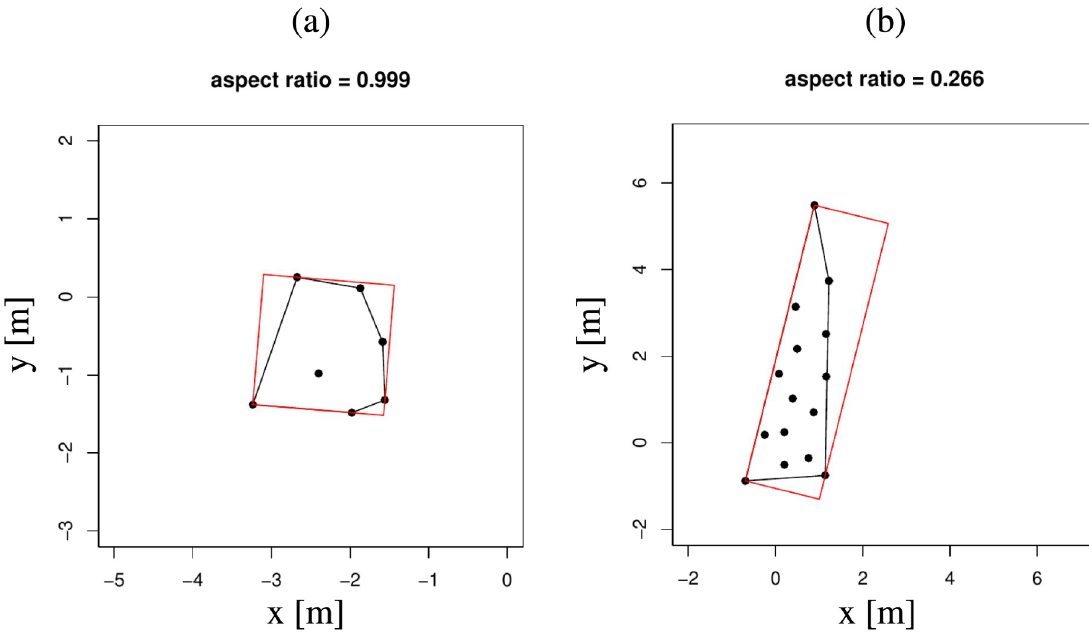
Fig 19. Constructing the minimum bounding box of a stripe. Two typical stripes are shown with aspect ratios (a) 0.999 and (b) 0.266. The red boxes denote the minimum bounding boxes and the polygons shown by black lines are the convex hulls of the points in the stripes. The stripe with the aspect ratio closer to 1 (a) is not suitable for the estimation of orientation. The stripe with the lower aspect ratio (b) is inclined at an angle of 76.01˚ with respect to the x -axis.